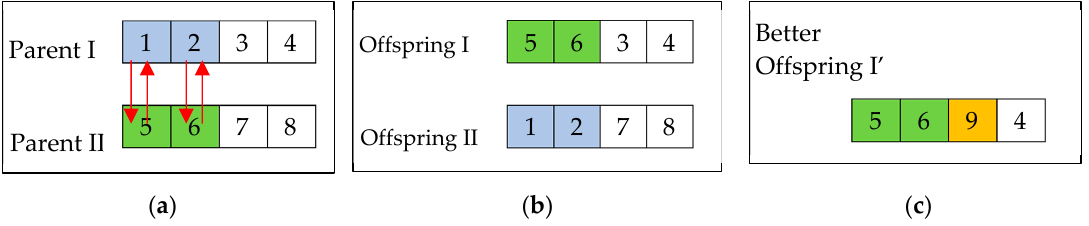
Figure 8. The optimal processes of layout instance: ( a ) the score of Parent I is 7.26, and the Parent II is 7.24; ( b ) the score of Offspring I is 7.69, and Offspring II is 6.82; ( c ) after mutation, the score of Offspring I’ is 8.3. (Note: the number is the selected ordinal number, not the number of trains in the objects database). Table 8. The attributions and type scores of the selected trains (a pair of chromosomes).